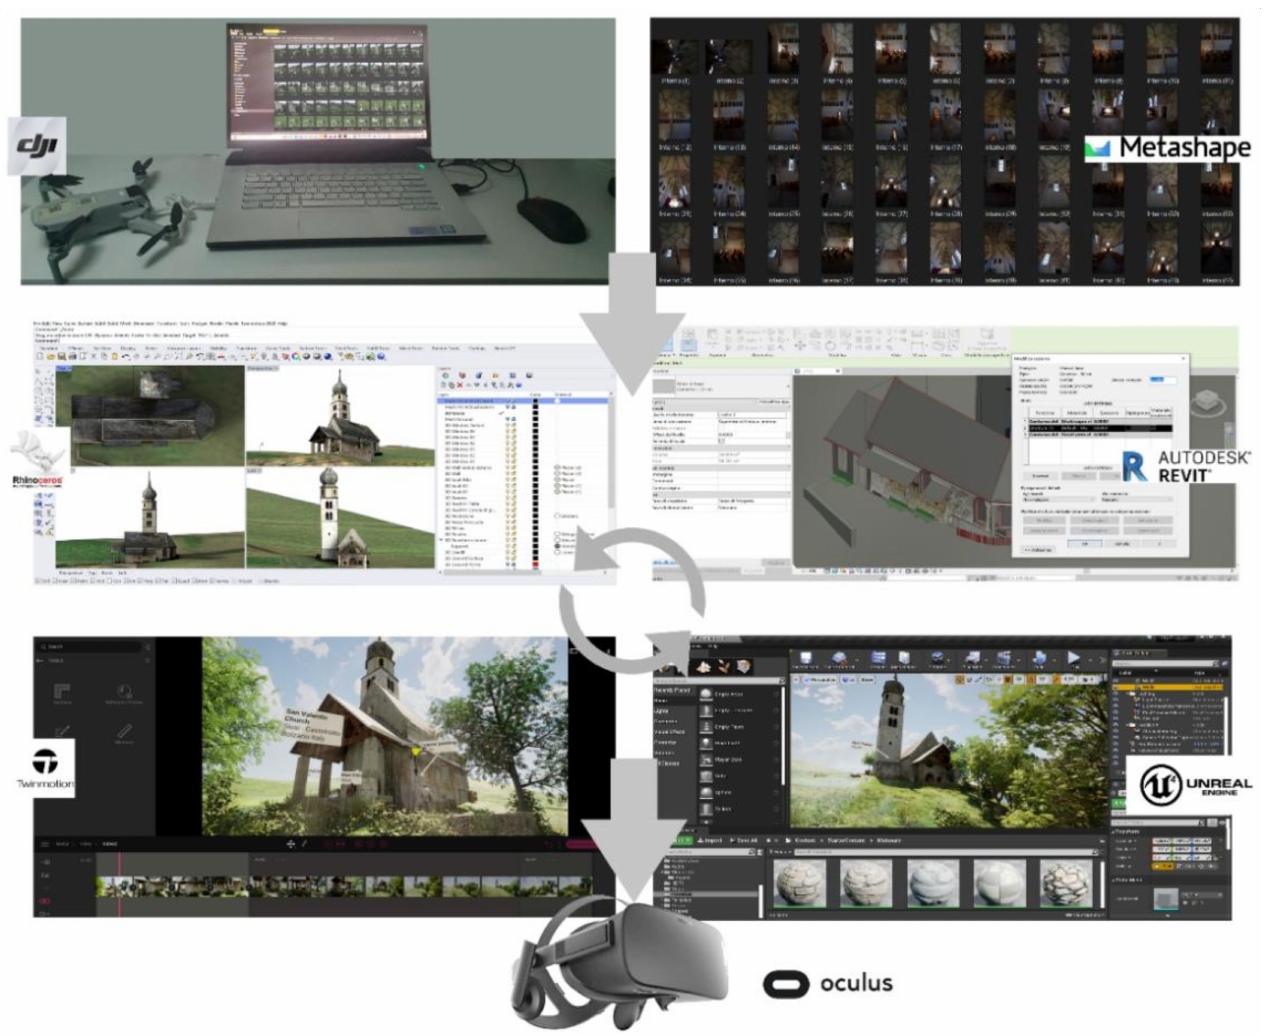
Figure 12. The level of synchronisation obtained between the various software applications and VR